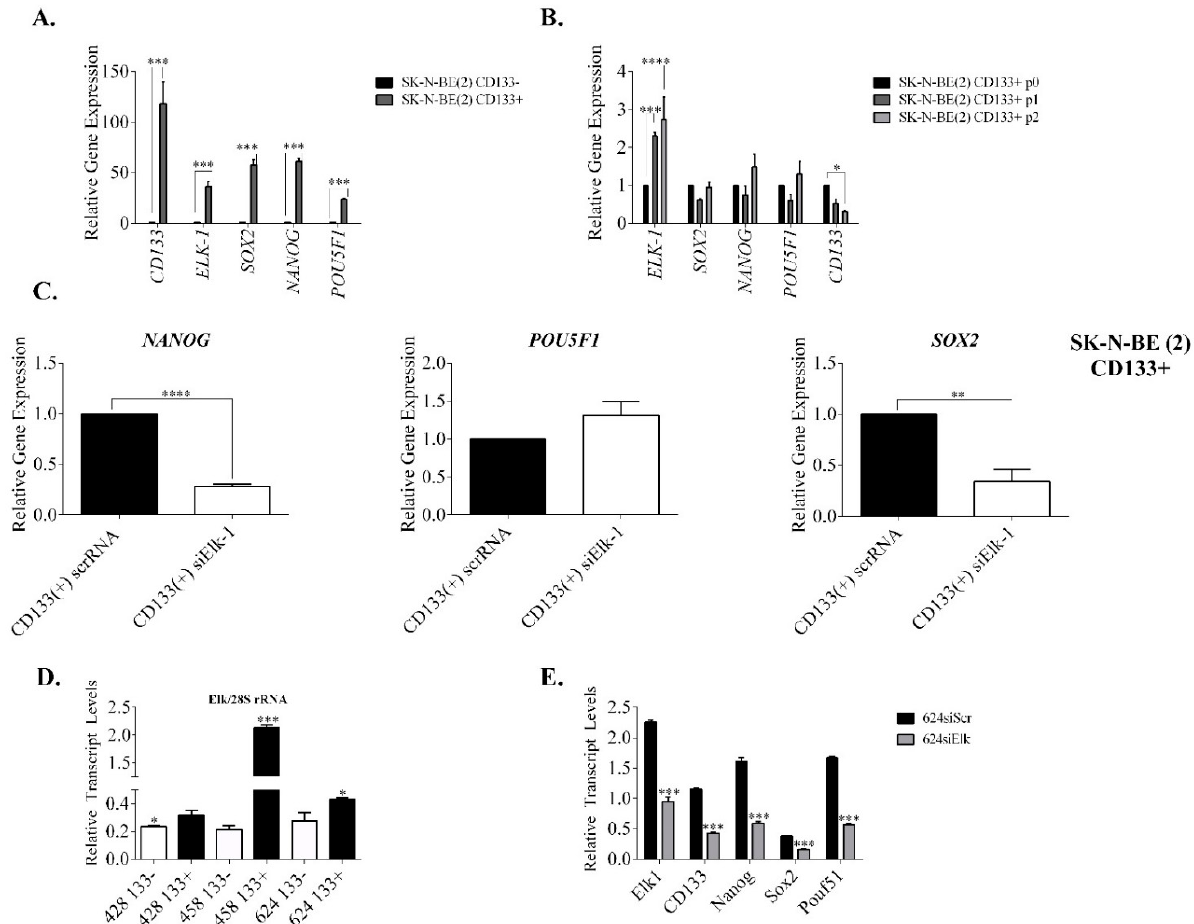
Figure 4. qPCR expression profiles of stemness genes in CD133 − vs. CD133+ SK-N-BE(2) cells and in primary brain tumors. ( A ). Stemness gene expression analysis of SKNBE(2) passage 0, passage 1, and passage 2 cells (*** p < 0.001, two-way ANOVA w/Dunnett multiple comparison test); ( B ). Stemness gene expression analysis of SKNBE(2) CD133+ BTICs vs. CD133 − spheroids (unpaired t-test, * p < 0.05, *** p < 0.001, **** p < 0.0001); ( C ). left , NANOG , middle POU5F1 and right , SOX2 gene expressions in CD133+ cells upon silencing of Elk-1 expression (unpaired t-test; **** p < 0.0001, ** p = 0.0051); ( D ). endogenous Elk-1 expression levels in CD133 − and CD133+ primary brain tumor samples (sample no 428, 458 and 624); relative gene expression is reported as normalized to 28S rRNA level (unpaired t-tests; * p < 0.05, *** p < 0.0001); ( E ). primary brain tumor cells from sample no 624 were transfected with either scrRNA or siElk-1 plasmids and analyzed for expression level of endogenous ELK-1 , CD133 , NANOG , SOX2 , and POU5F1 normalized to 28S rRNA level (unpaired t-tests; *** p <